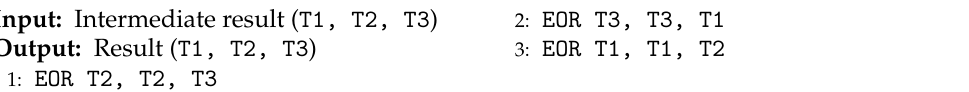
Algorithm 7 Optimized M 1 layer of ARIA block cipher for counter mode of operation on ARM